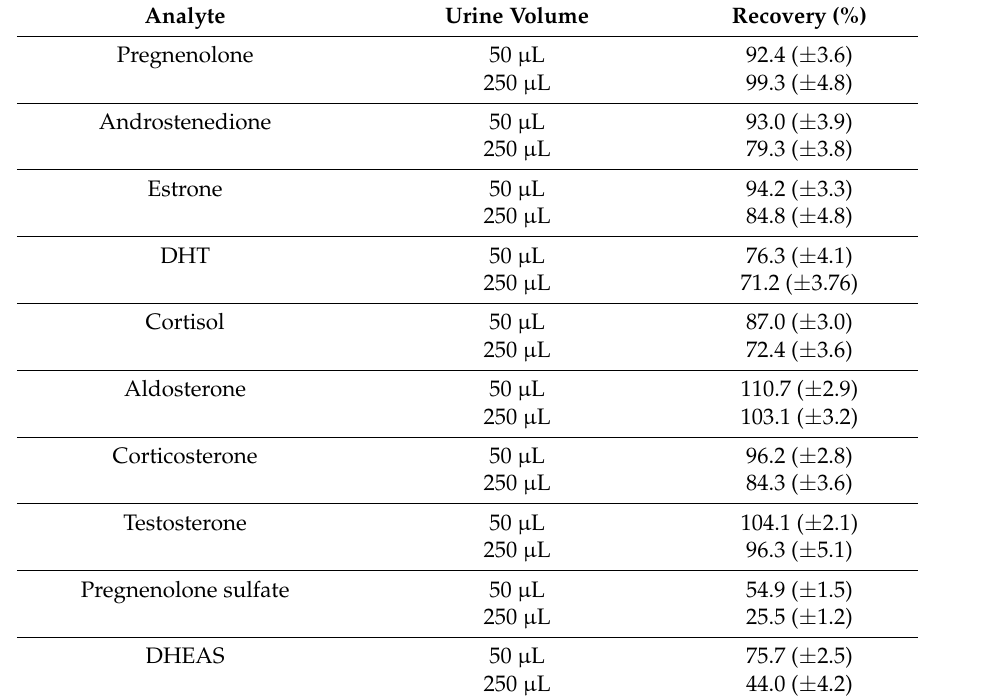
Table 2. Summary of the recoveries using the optimized methodology in urine matrix. The recoveries ( ± standard deviation) of two different volumes (50 µ L and 250 µ L) of pre-pooled urine are reported ( n = 3).